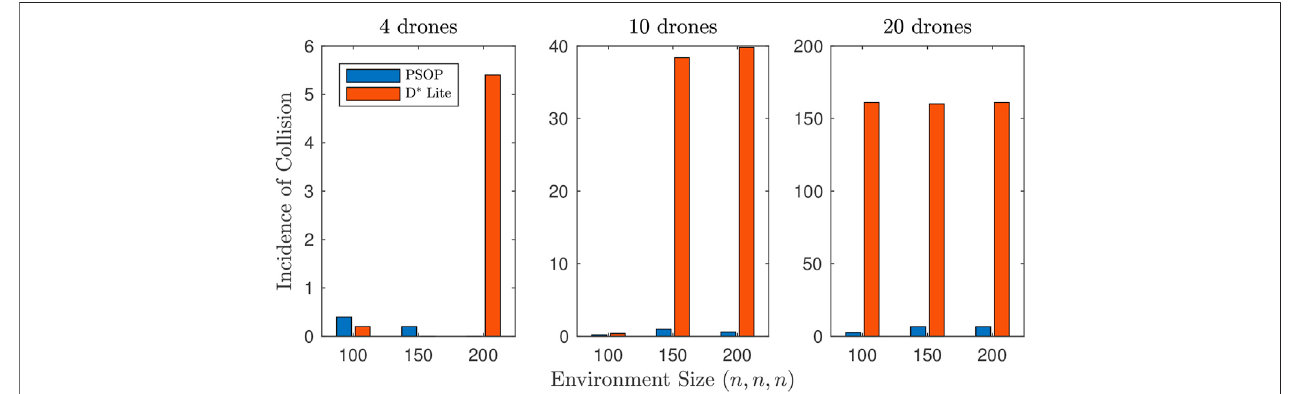
FIGURE8| Meanincidence ofcollisionbyenvironmentsize(drone-to-drone).Forcollisionsbetweentwodrones,p-dronesrecordedfewerincidencesforsystems of 4, 10, and 20 drones with 0.2, 0.6, and 5.3 collisions per scenario respectively for p-drones (average across all environment sizes) and 1.9, 26.2, and 160.7 collisions per scenario respectively for d-drones (average across all environment sizes).